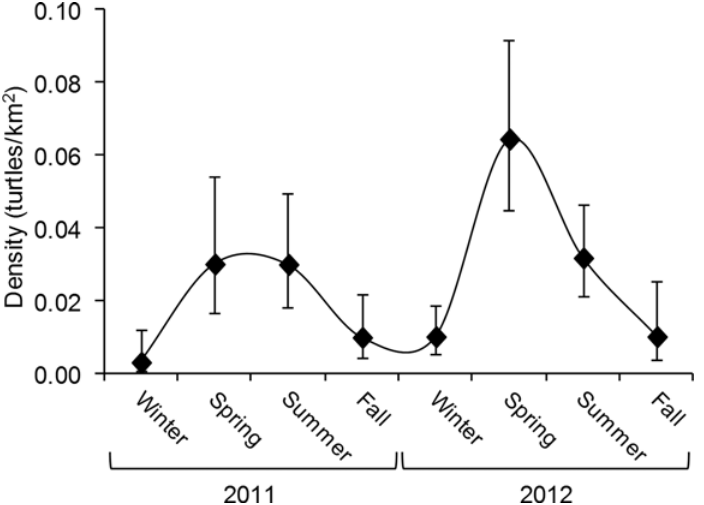
Fig 5. Seasonal trend in sea turtle surface density with 95% confidence intervals estimated from conventional distance sampling analysis of aerial surveys. Turtle densities varied with season in both years. The large peak in spring 2012 corresponded with a larger than normal number of nesting loggerhead